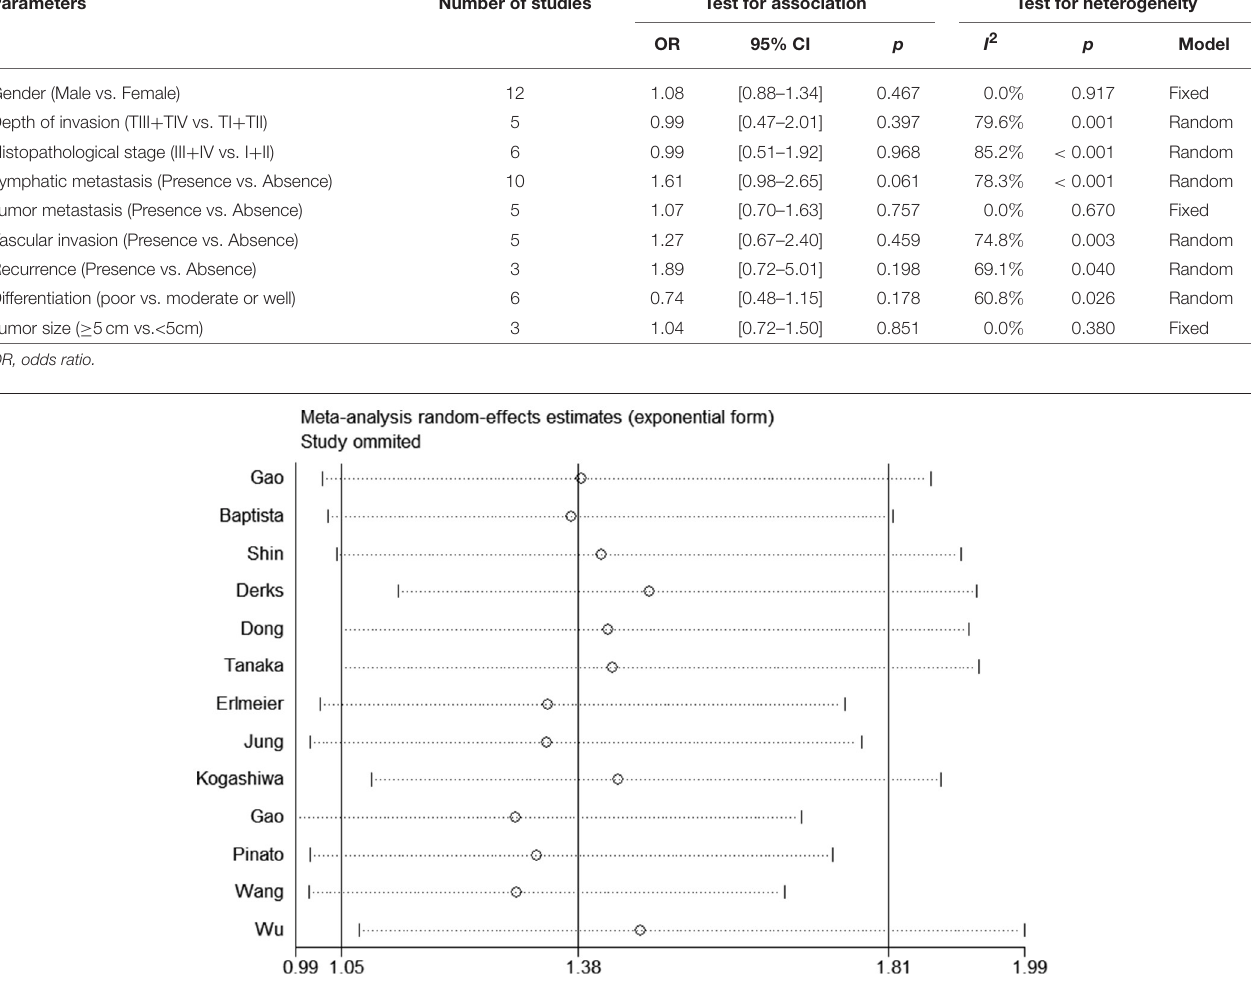
TABLE 3 | Meta-analysis of reported clinicopathological characteristics in the included studies. Parameters